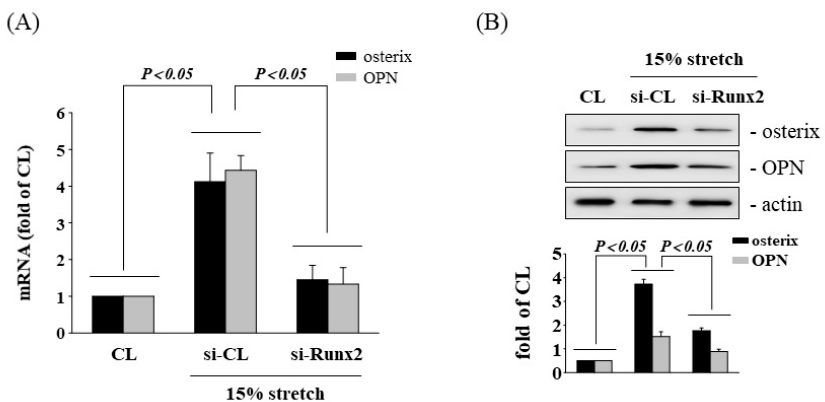
Figure 2. Involvement of Runx2 in tensile stretch-induced osteogenesis. AF cells were kept in static condition as CL or subjected to HCS for 8 h. Before being kept as CL or subjected to HCS, AF cells were transfected with control siRNA (si-CL), or a specific siRNA of si-Runx2. ( A ) All bar graphs represent multiple increases in mRNA expression of CL AF cells normalized to 18S rRNA. ( B ) The protein expression was examined by Western blot analyses. The results are mean ± SD and are representative of three independent experiments (n = 3). Data statistics were completed with ANOVA followed by Scheffe’s test. Results were considered significant for p <